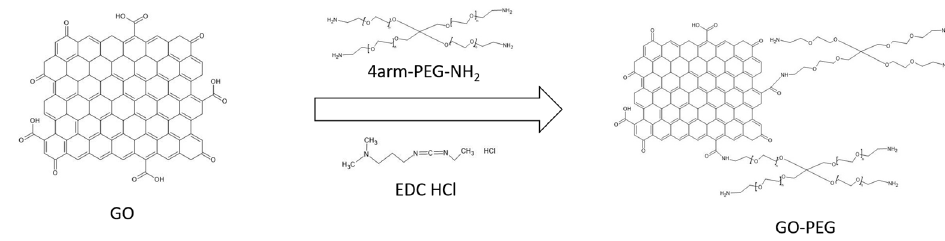
Figure 1. Scheme of the synthesis of graphene oxide pegylated.